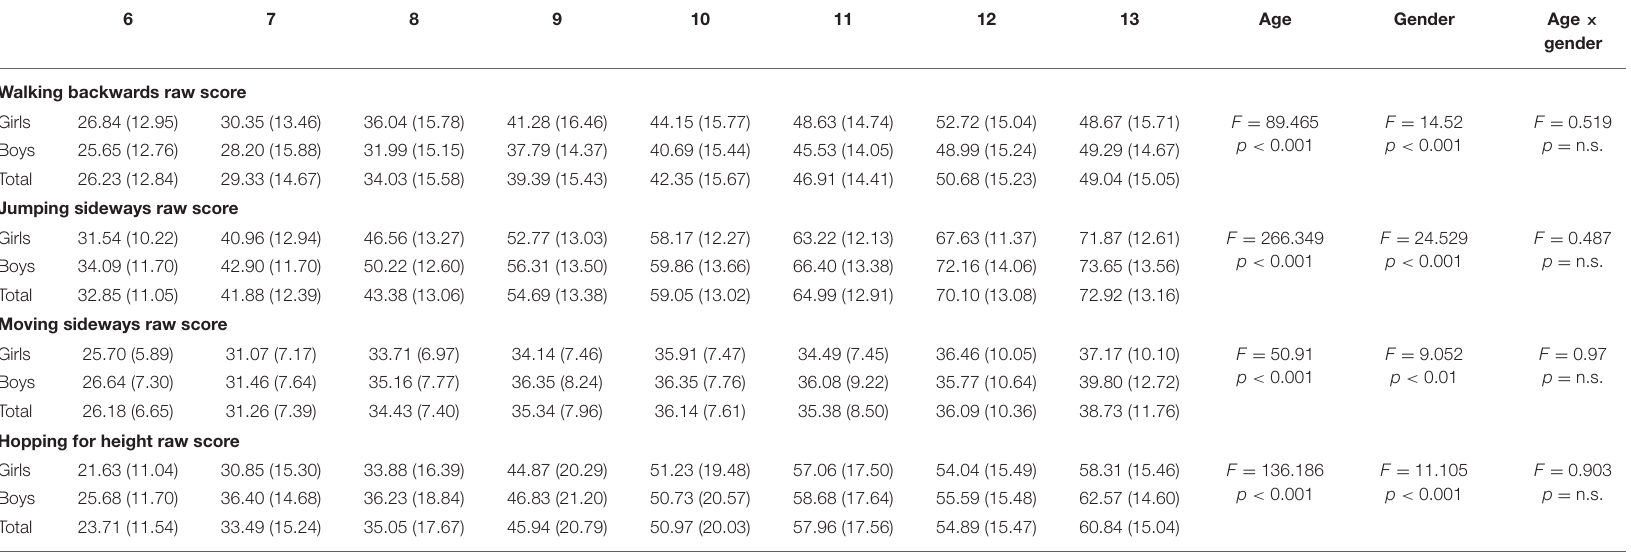
TABLE 3 | Raw score (mean ± standard deviation) of the four KTK subtests (walking backwards, moving sideways, jumping sideways, and hopping for height) for gender and age.